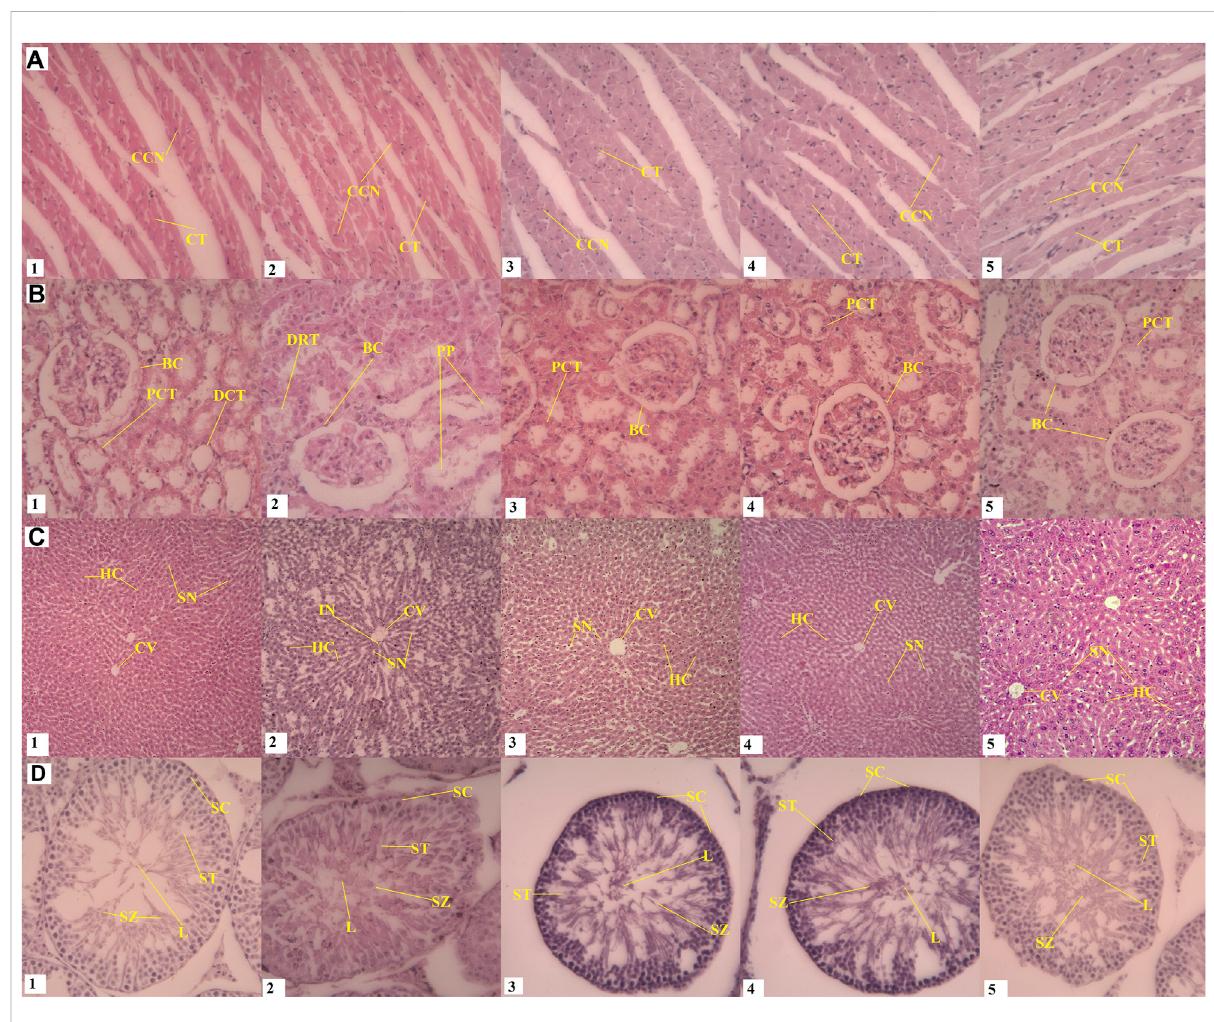
FIGURE 5 Effect of daturaolone on the histology of organs. Kidney histopathology (B2) showed mild tubular kidney nephrosis, cell proliferation, degeneratedepithelialcells, adsorption ofpinkproteinaceousmaterialinthelumenofcompressedproximaltubules.Mildtubularrenalnecrosisand vacuolarcytoplasmfromthetubularlumenbasemembrane.Testes(D2)showed veryfewinterstitialspacesbetweentheseminiferoustubulesanda decrease in the size of the lumen. In D3 and D4, a slight increase compared to normal seminiferous tubes with germ epithelium that contain germ cells were found proliferating at different stages at higher pace were observed which might signify aphrodisiac character. In the liver (C2), increase in sinusoidal space, mild in fl ammatory cell in fi ltration, edema and sinusoidal congestion were observed in comparison to control (C1) No histological changes were seen in heart. A-D represents heart, kidney, liver and testes respectively. 1-5 represents different dose groups i.e., normal or vehicle, 10, 5, 2.5 and 1.25 mg/kg. CCN; Cardiac cell nucleus, CT, Cardiac tissue; FN, Fibroblast nucleus; BC, Bowman ’ s Capsule; DCT, Distal convoluted tubules; PCT, Proximal convoluted tubules; PP, Pink proteinaceous material; DRT, Damaged renal tubule; BD, Biliary duct; HC, Hepatocytes; SN, Sinusoids; CV, Central vein; IFC, In fl ammatory cells; SC, Spermatocytes; SZ, Spermatozoa; ST, Spermatids; L,